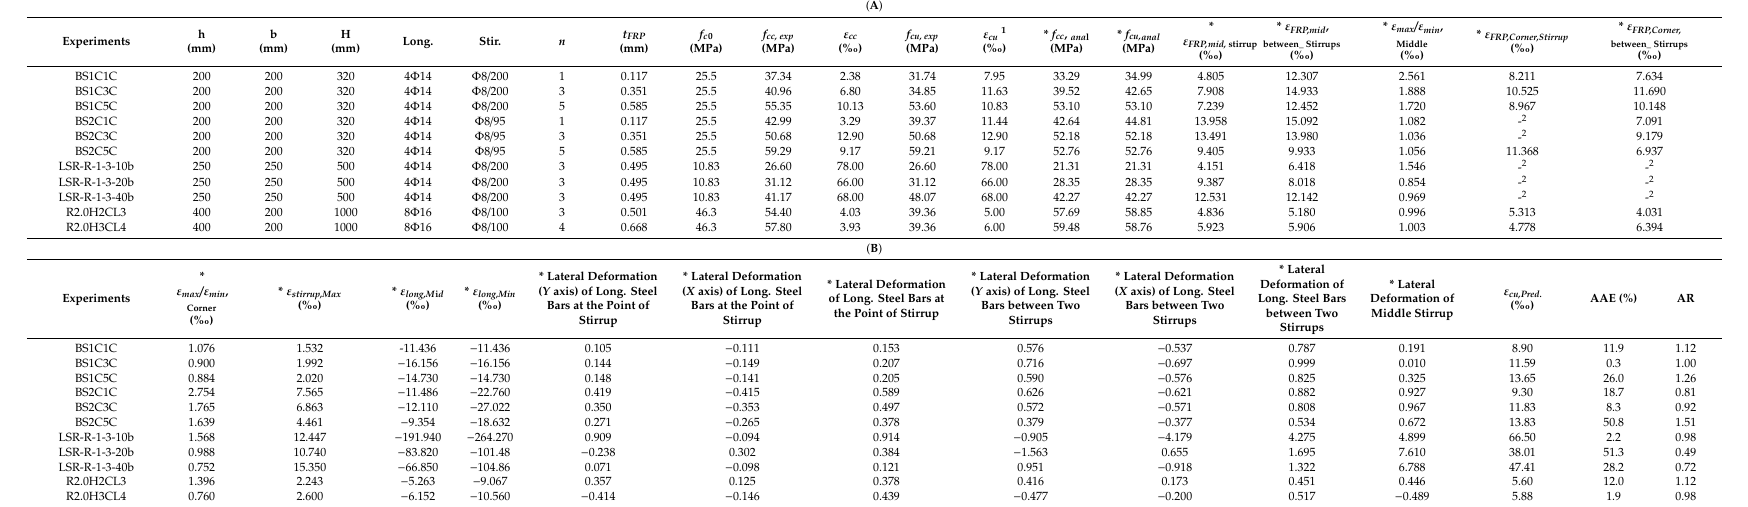
Table 3. Geometrical and mechanical data of 11 RC columns and experimental–analytical